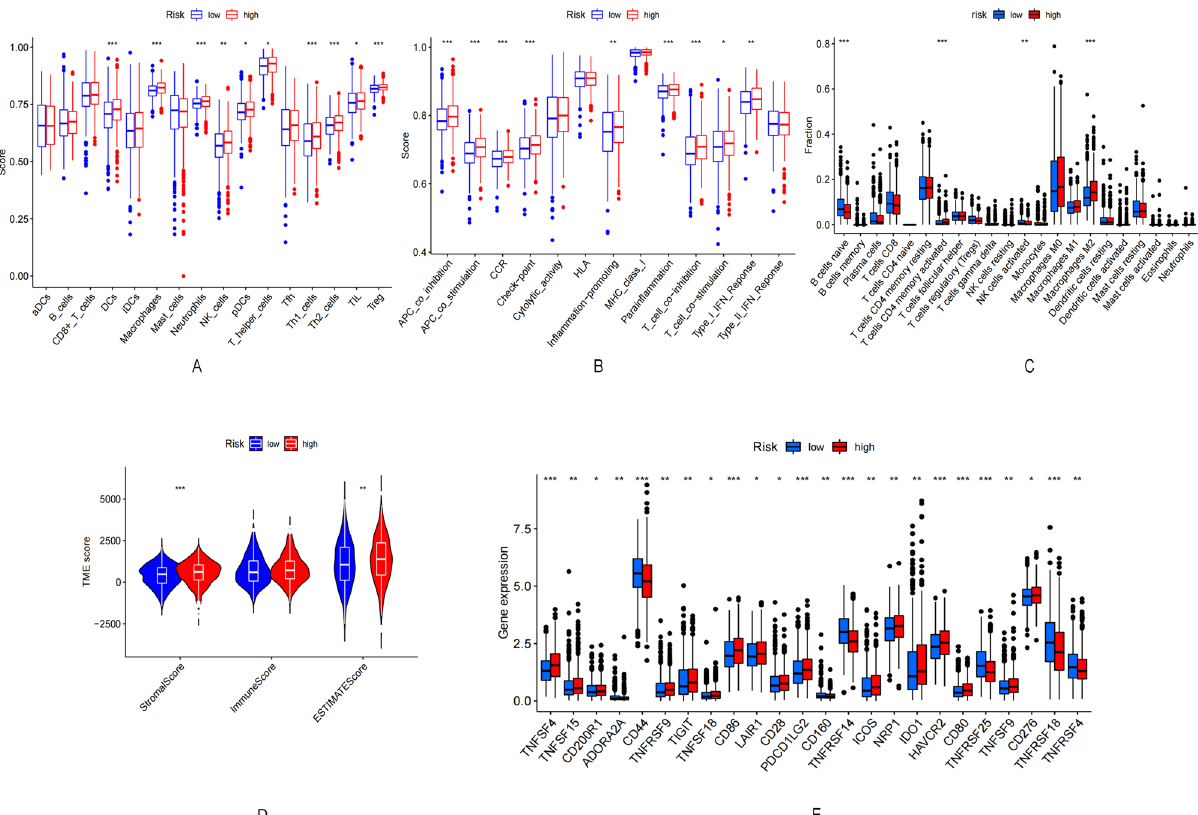
Figure 6. Risk score associated with immune cell infiltration and function. ( A , B ) ssGSEA scores of immune cells and immune function in the high/low risk group. ( C ) Distribution of immune cell infiltration in the high/ low risk group. ( D ) Correlation between high/low risk group and immune cells. ( E ) Comparison of high/low risk groups in immune correlation scores. ( F ) Differences in immune blocking site expression in high/low risk